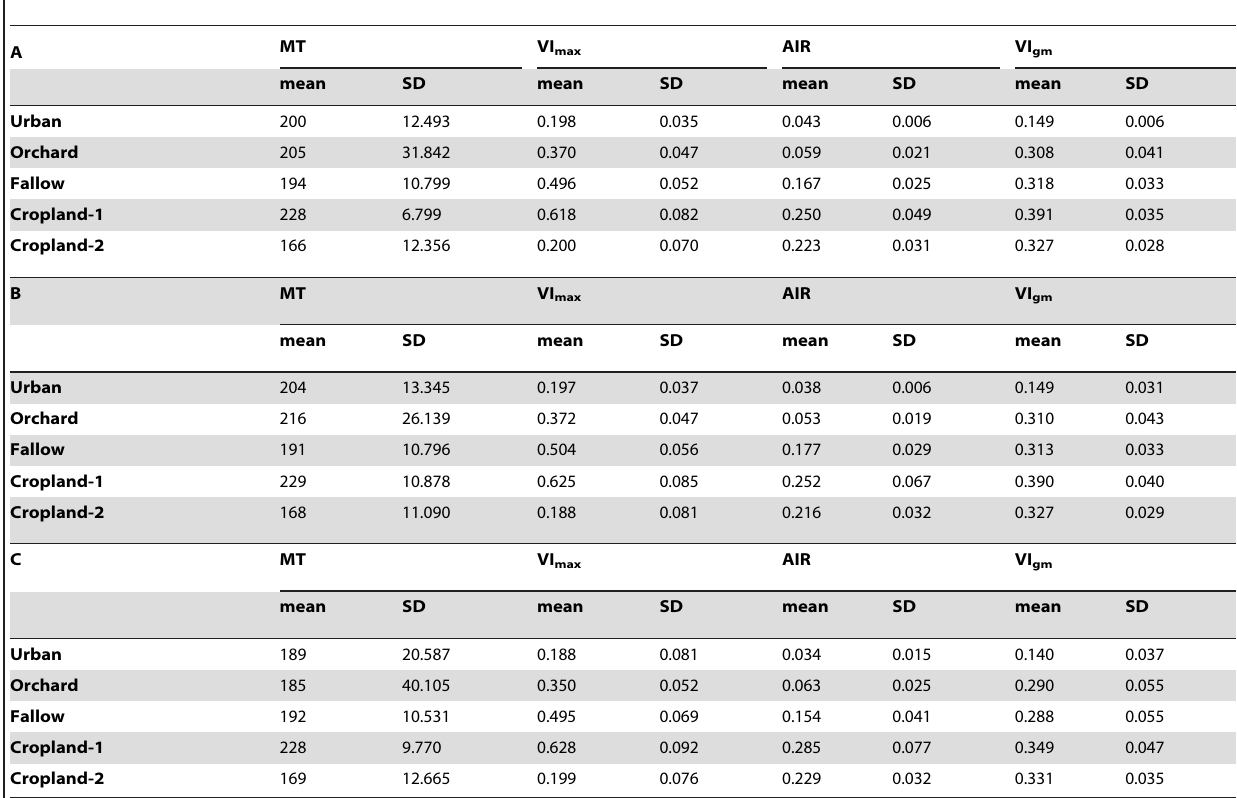
Table 3. The mean value and standard deviation (SD) of parameters extracted from time series vegetation index (VI) data with asymmetric Gaussian method (A), double logistic function (B), and Savitzky-Golay filter